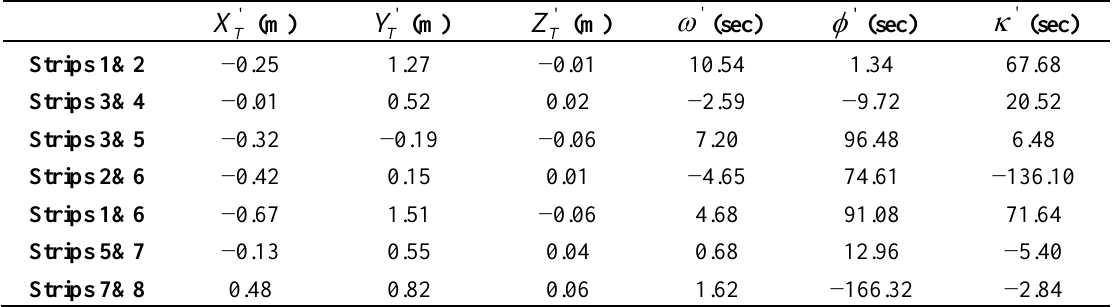
Table 3. Estimated transformation parameters w.r.t. the local coordinate system using the discrepancy detection